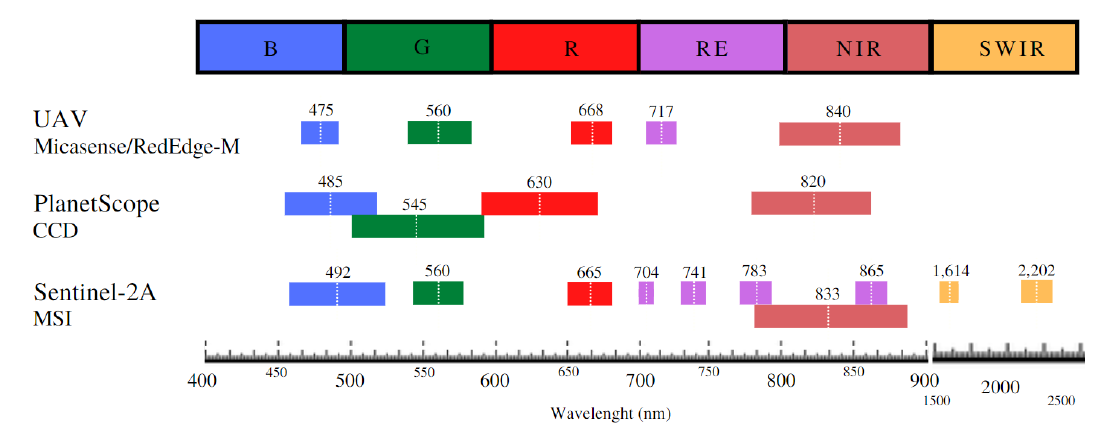
Figure 2. Spectral (bandwidth and central wavelength) characteristics of UAV orthomosaic, Plan- etScope, and Sentinel-2A